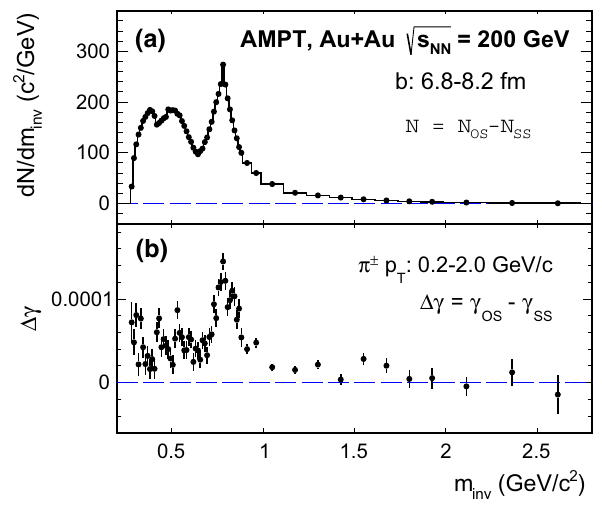
Fig. 1 a Excess of opposite-sign (OS) over same-sign (SS) pion pairs, and b (cid:2)γ ≡ γ OS − γ SS as a function of pair invariant mass ( m inv ). Used are total 11 × 10 6 AMPT events of 200 GeV Au+Au collisions with b = 6 . 8–8.2 fm